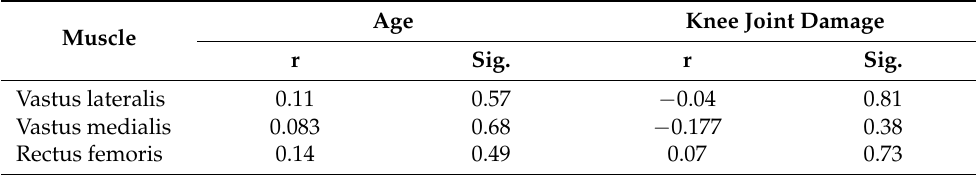
Table 5. Correlation between the observed difference in means and quantitative variables. Age Knee Joint Damage Muscle r Sig. r Sig. Vastus lateralis 0.11 Vastus medialis Rectus